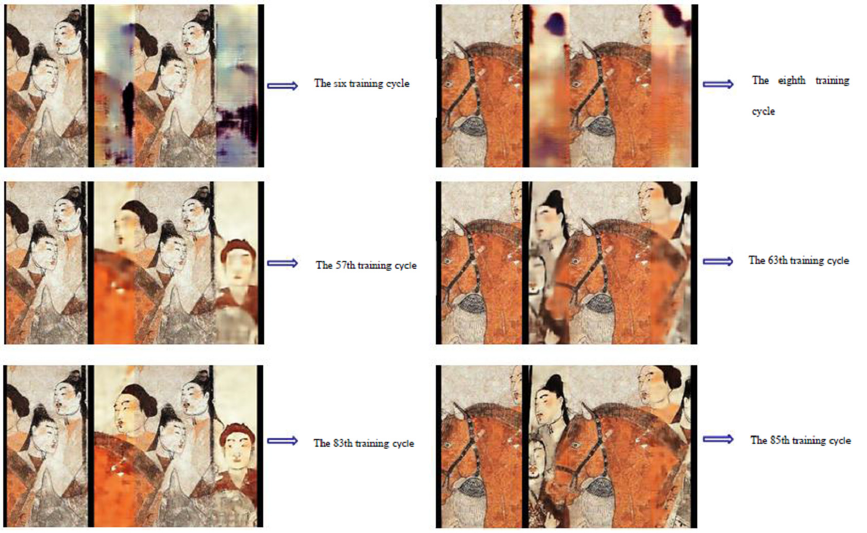
Fig. 8 The generations in different training cycles